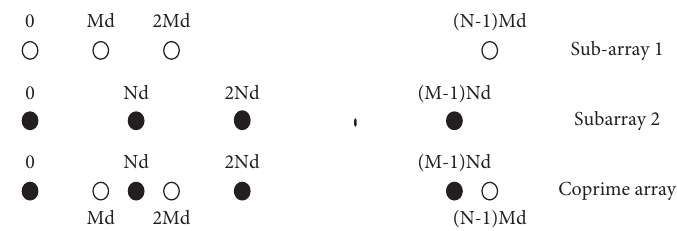
Figure 2: The structure of the coprime array and two